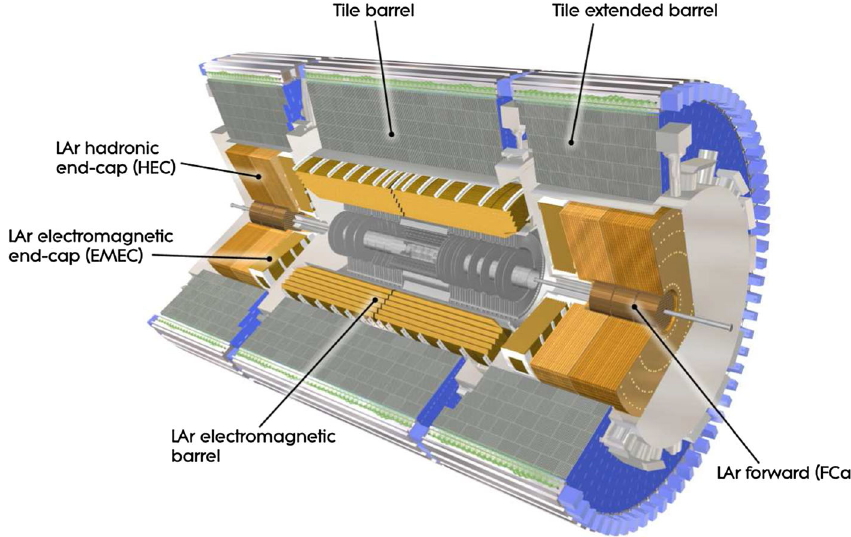
Fig. 1 Cutaway view on the ATLAS calorimeter